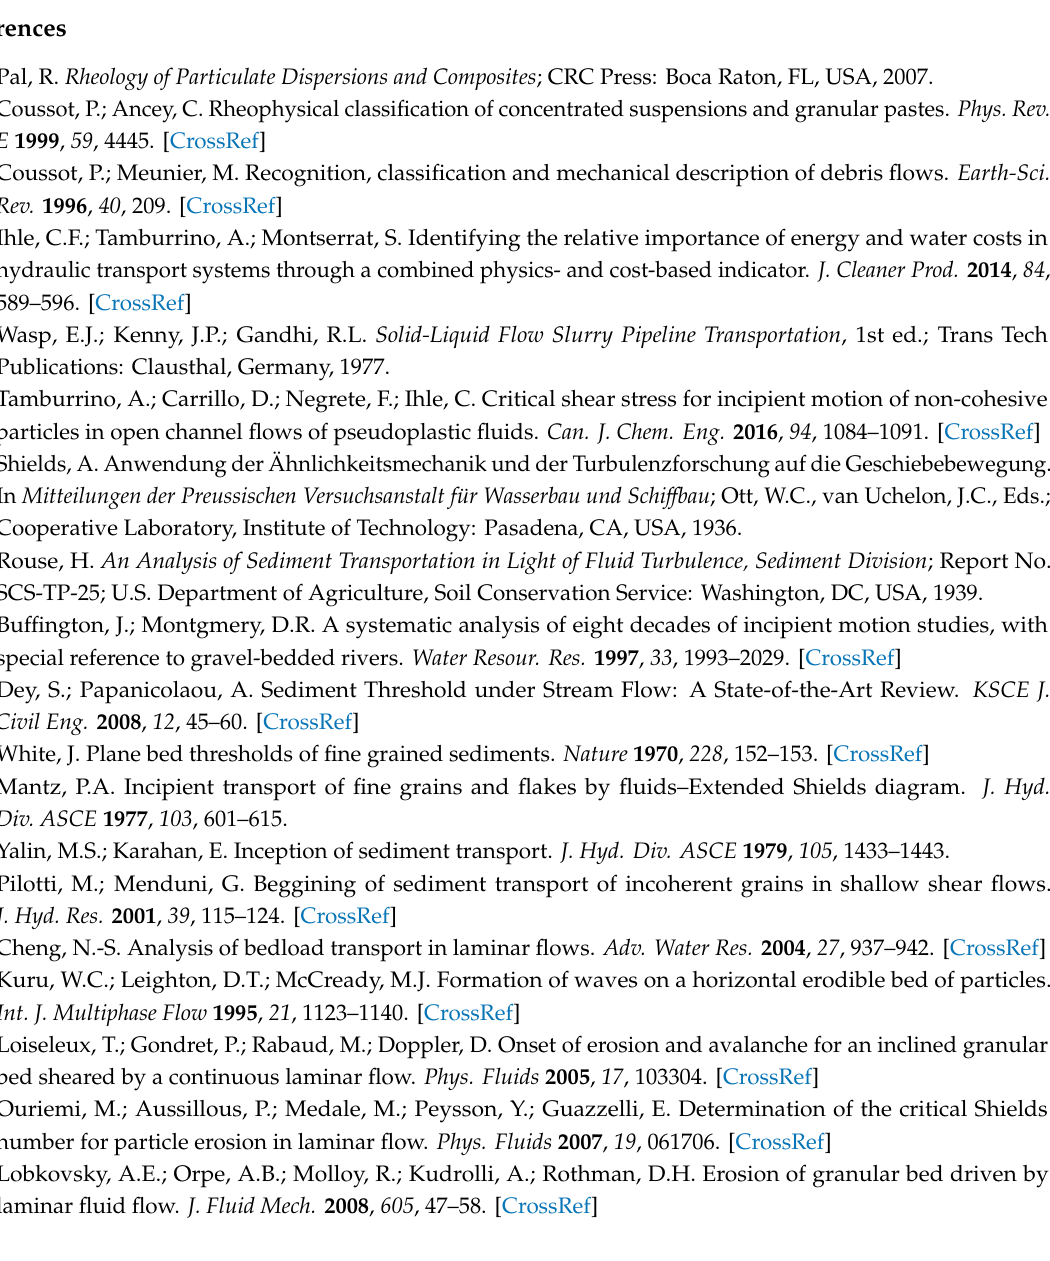
Table S1: Experimental conditions and dimensionless parameters, Video S1: Incipient